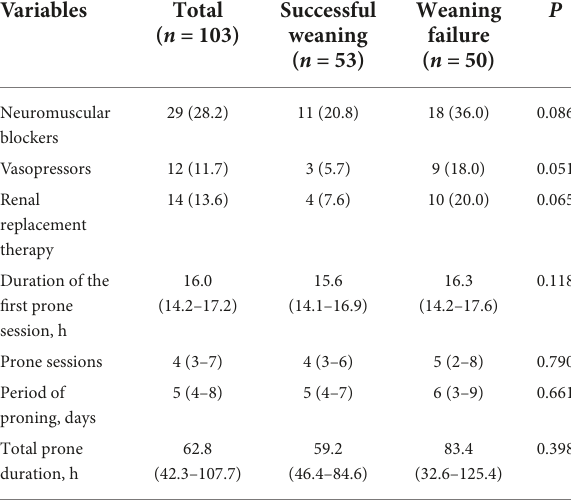
TABLE 2 Characteristics of adjunctive therapies and prone